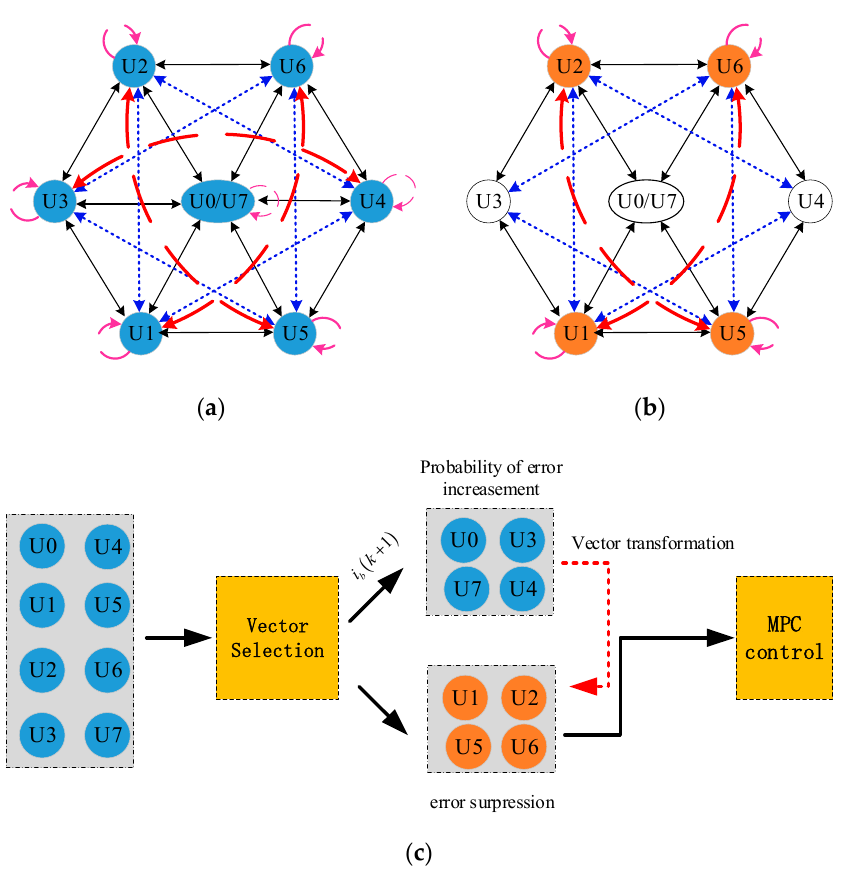
Figure 6. Voltage vector selection: ( a ) traditional model predictive control (MPC) method; ( b ) improved MPC method for current reconstruction; ( c ) flow chart of improved MPC vector selection.